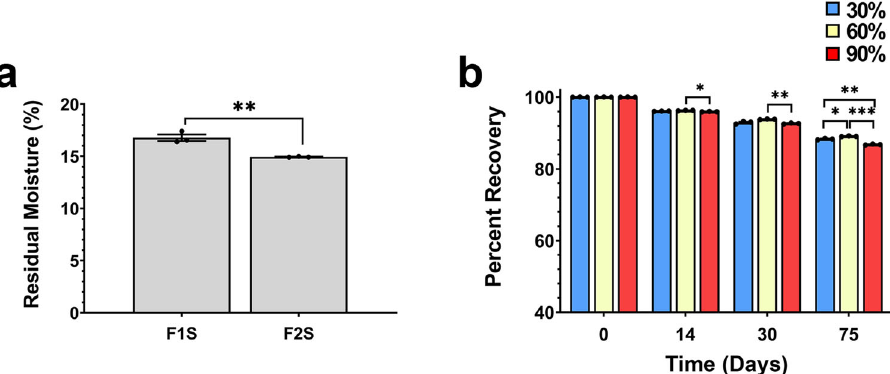
Fig. 4 Formulation and environmental humidity in fl uence residual moisture content and long-term stability of AAV within the fi lm matrix. a Residual moisture in high (F1S) and low (F2S) viscosity fi lms after drying. Data represent the average ± the standard error of the mean for three replicates for